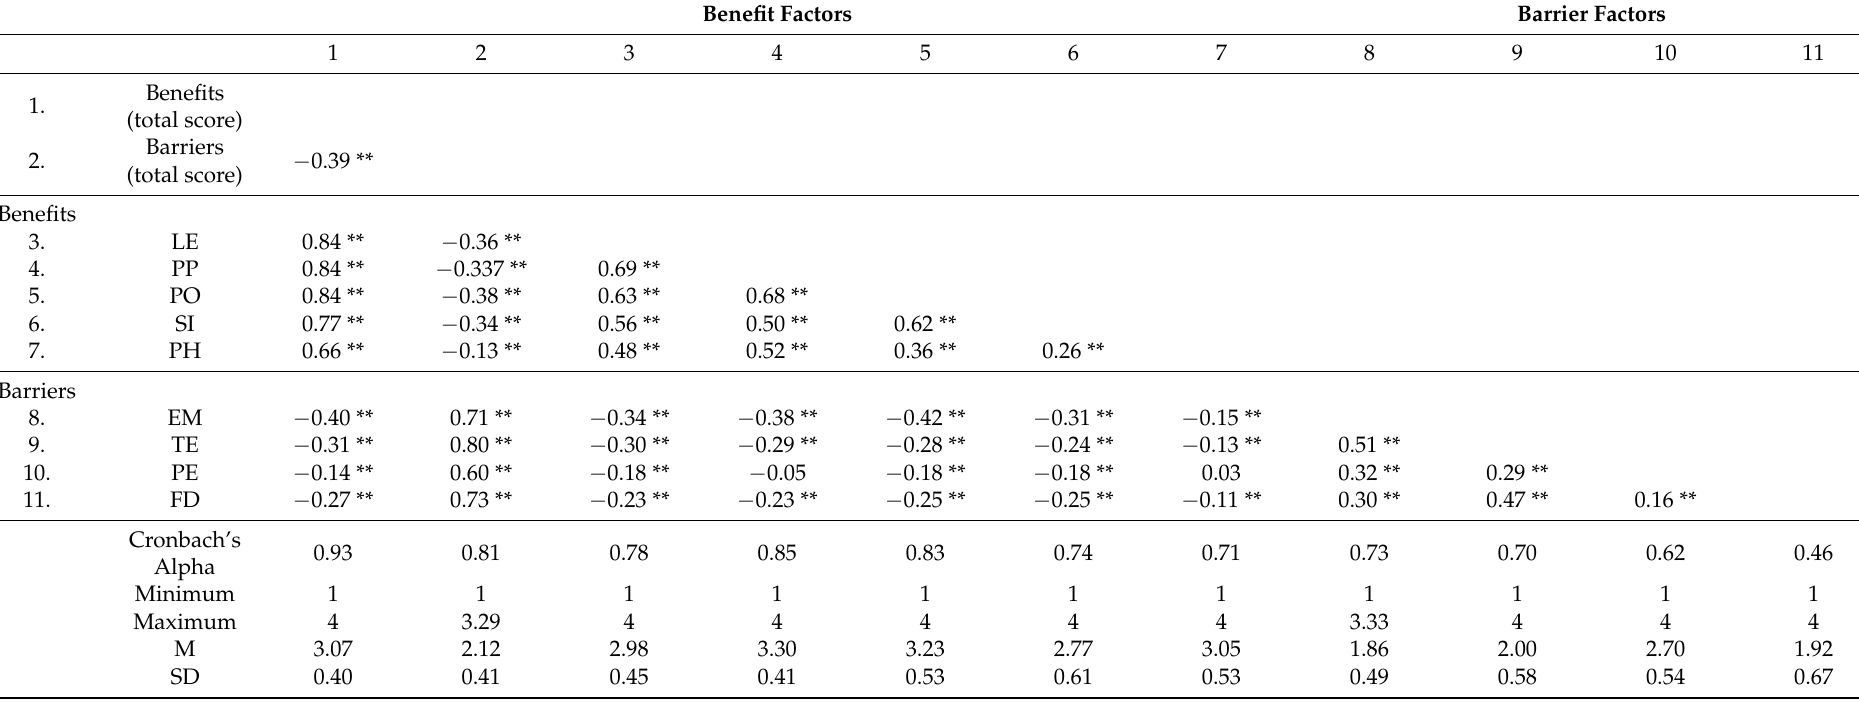
Table 2. The correlation matrix, Cronbach’s alpha, and descriptive statistics. Benefit